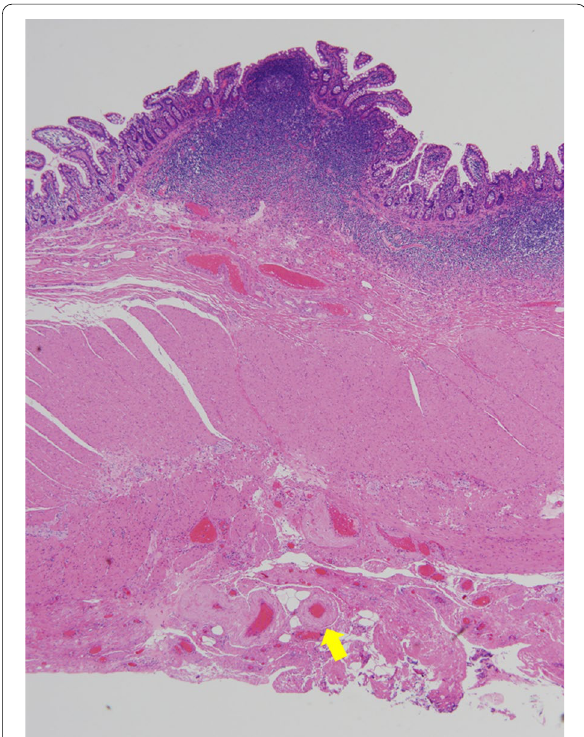
Fig. 6 Pathological findings of the no stenotic part of the resected bowel. The venous wall of the mesentery showed degeneration of the smooth muscle cells and thickening; however, the lumen was patent (arrow) (HE, 20). Mild ischemic mucosal changes were × detected, such as low, flat, and wide